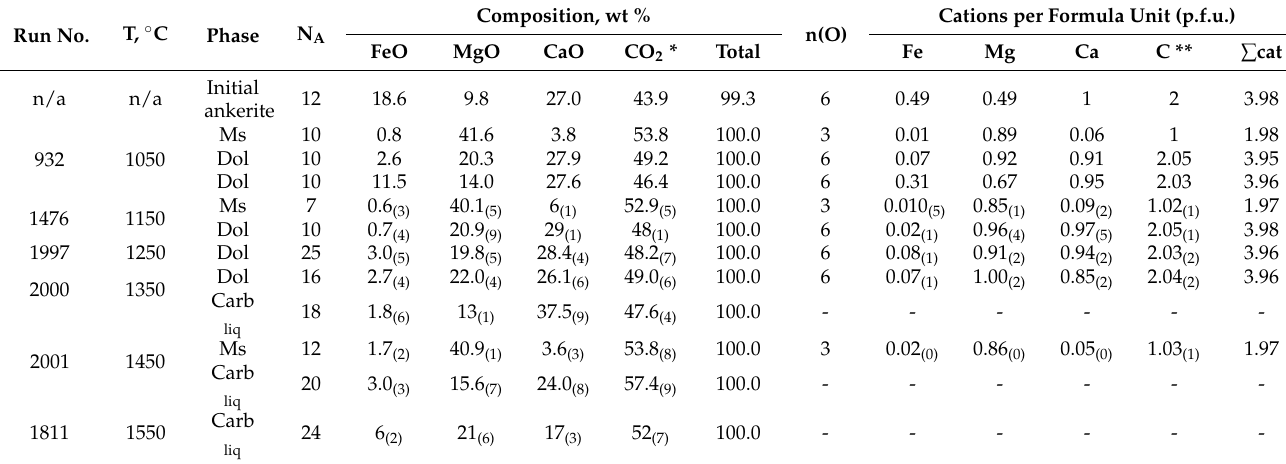
Figure 4. SEM-micrographs (BSE regime) of polished sample fragments and diamond seed crystal, after experiments in ankerite–pyrite system: ( a ) polycrystalline aggregate of dolomite, magnesite, pyrite, pyrrhotite, and graphite (run No. 932-4); ( b ) polycrystalline aggregate of dolomite with drops of quenched sulfide melt and graphite crystals (run No. 2000-4); ( c ) drop of quenched sulfide melt in dolomite aggregate (run No. 2000-4); ( d ) zonal dolomite crystals at the contact with quenched sulfide melt and graphite crystals (run No. 2000-4); ( e ) quenched carbonate and sulfide melt, as well as magnesite polycrystalline aggregate (run No. 2001-4); ( f ) diamond seed crystal with growth layers and sulfide melt droplets (run No. 1181-4). Ms—magnesite; Dol—dolomite; Gr—graphite; Py—pyrite; Po—pyrrhotite; Carb liq —carbonate melt; Sulf liq —sulfide melt; Dm—diamond seed crystals. Table 2. Averaged compositions of carbonates and carbonate